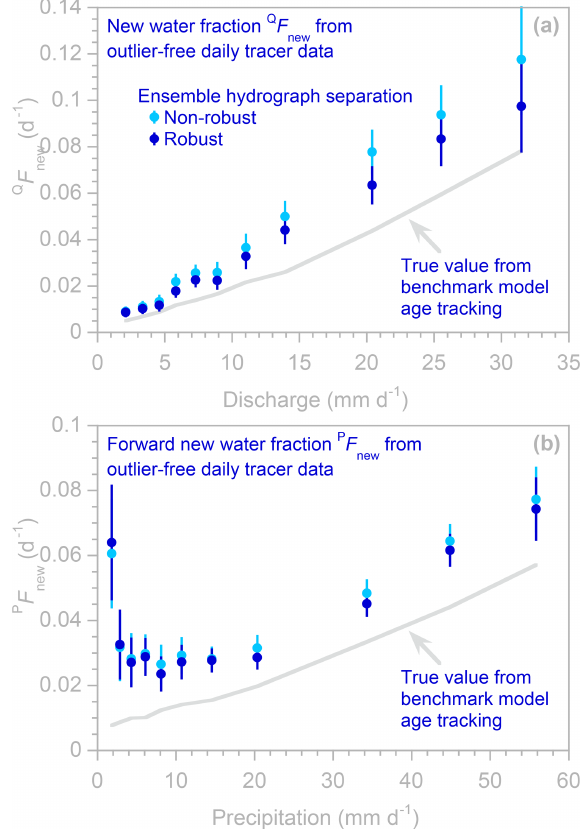
Figure 9. Profiles of new water fractions ( Q F new , panel a ) and for- ward new water fractions ( P F new , panel b ), estimated using robust and non-robust methods (dark and light blue symbols, respectively; error bars indicate 1 standard error) applied to daily tracer time se- ries, generated by the benchmark model using parameters that gen- erate a humped distribution (see Fig. 6). Some light blue symbols are invisible where they are overprinted by dark blue symbols. The light gray lines show the true new water fractions, as calculated from water age tracking in the benchmark model. These new water fractions are overestimated by both robust and non-robust